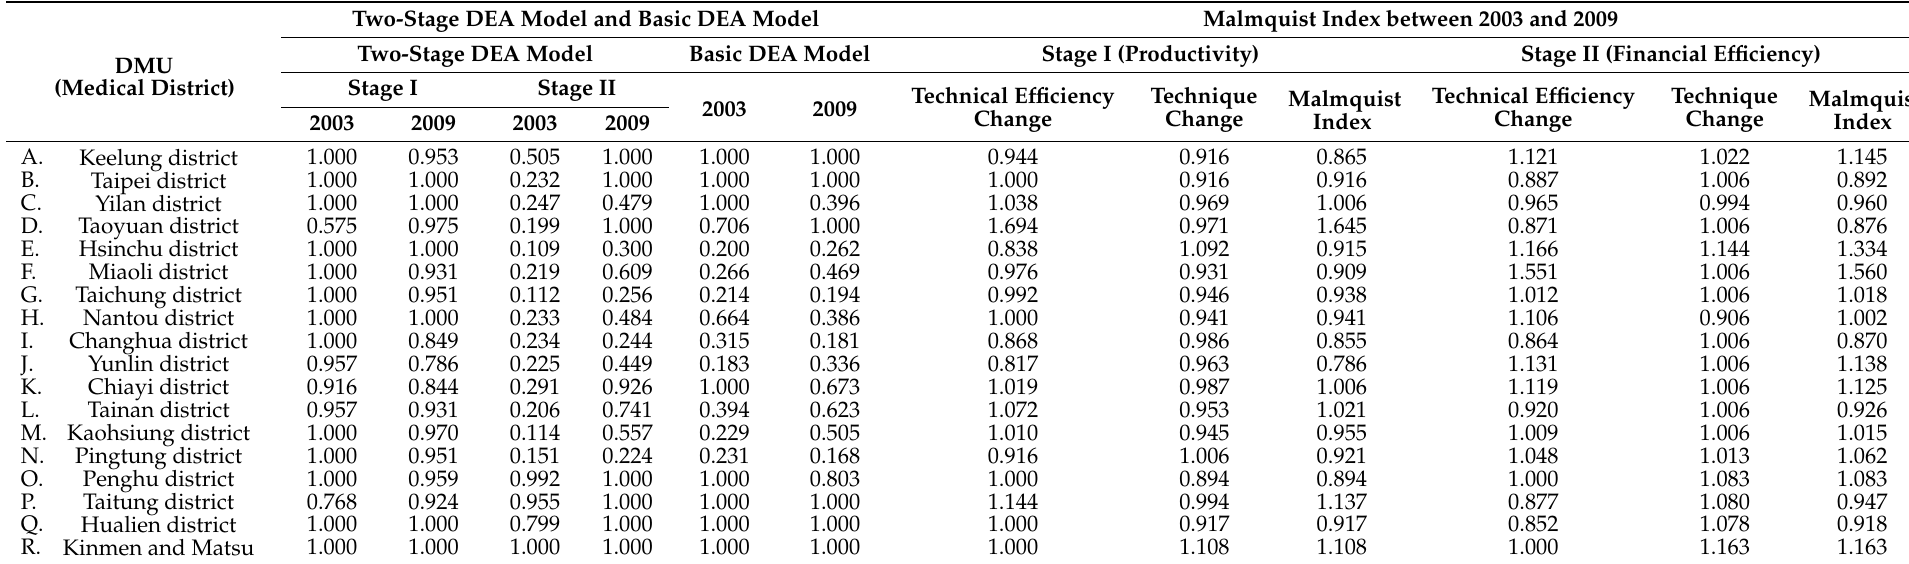
Table 2. Compare efficiency within two DEA models and the Malmquist index between 2003 and